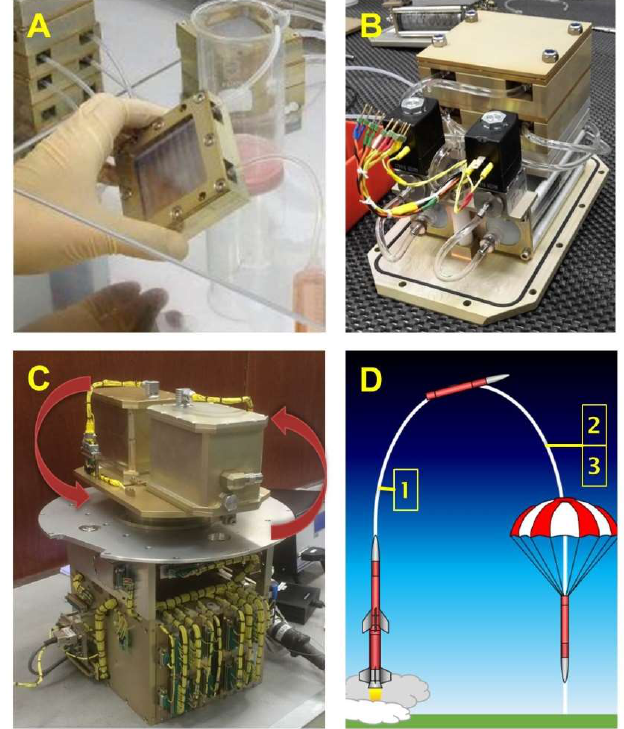
Figure 5. Workflow during the TEXUS-53 mission. Cell culture chamber were filled with cells ( A ) and afterwards placed into the late access unite ( B ). During flight a 1 g -centrifuge ( C ) served as one control besides others. Red arrows indicate the rotation direction of the centrifuge. The cells were fixed at defined time points 1, 2, 3 ( D